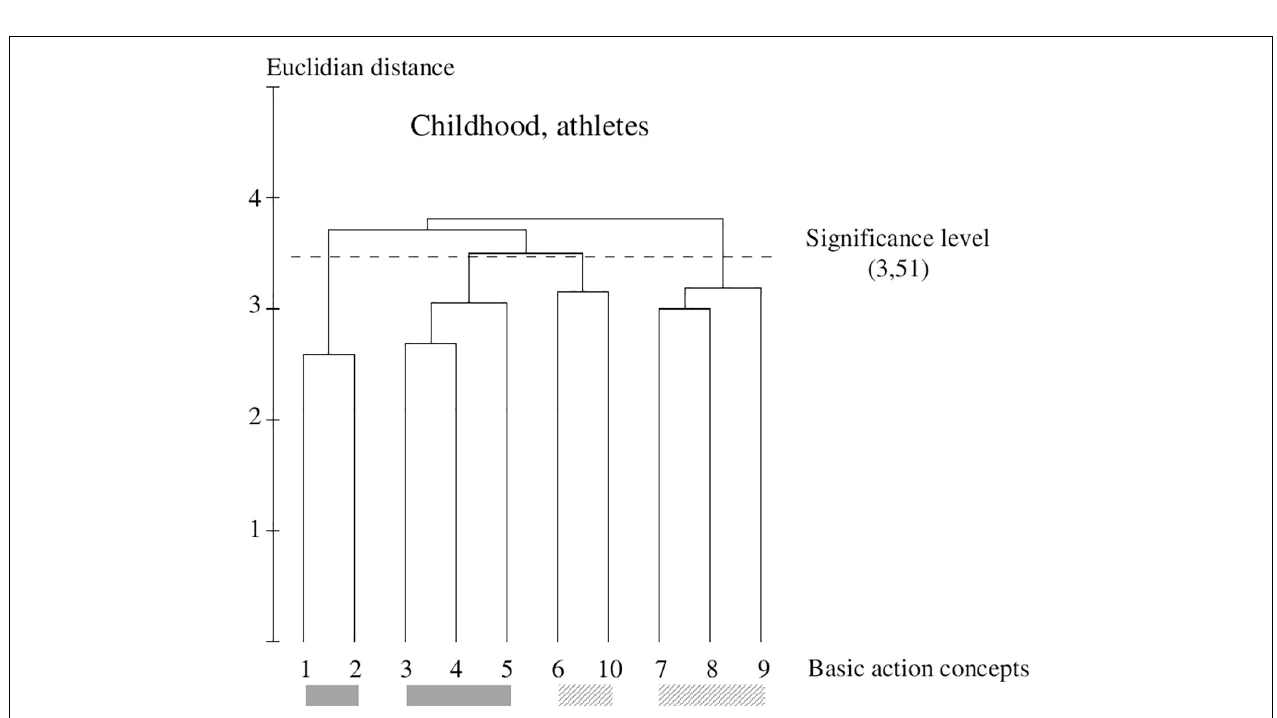
FIGURE 5 | Outcome of the hierarchical cluster analysis of athletes within childhood ( N = 45) displayed as a dendrogram. The dashed line clarifies the critical value of d crit = 3.51, which corresponds to a significance level of 5%. The BACs are marked with numbers among a dendrogram and highlighted with the gray solid bar (technically correct BAC) and diagonally striped bar (faulty BAC).